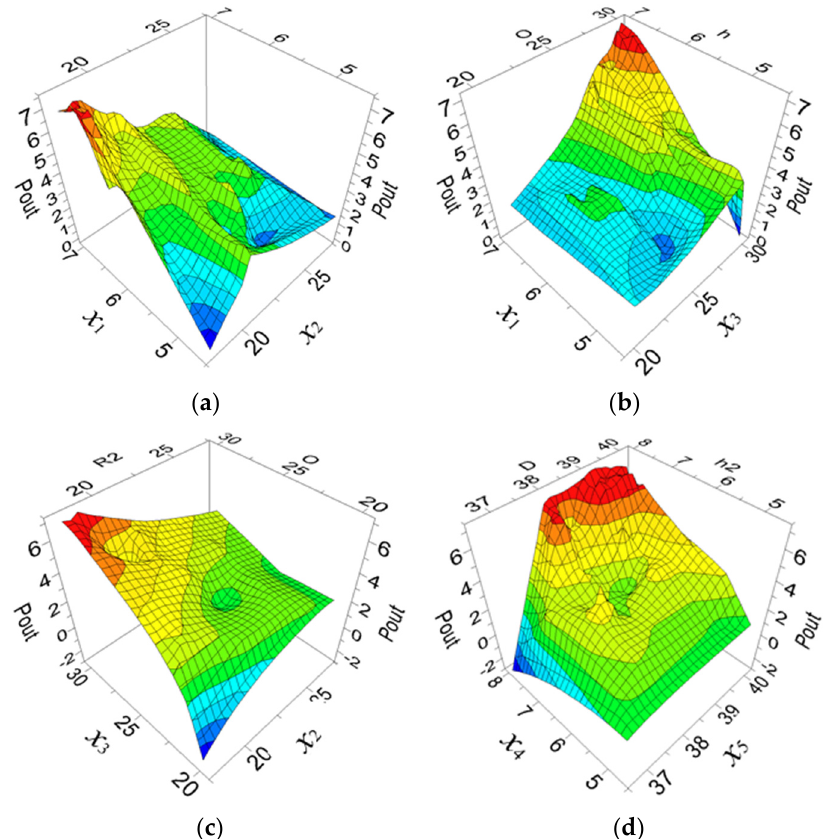
Figure 10. Surface diagram of output power for different variables: ( a ).Relationship between variables x 1 and x 2 and output power ( b ).Relationship between variables x 1 and x 3 and output power ( c ).Relationship between variables x 2 and x 3 and output power ( d ).Relationship between variables x 4 and x 5 and output power.